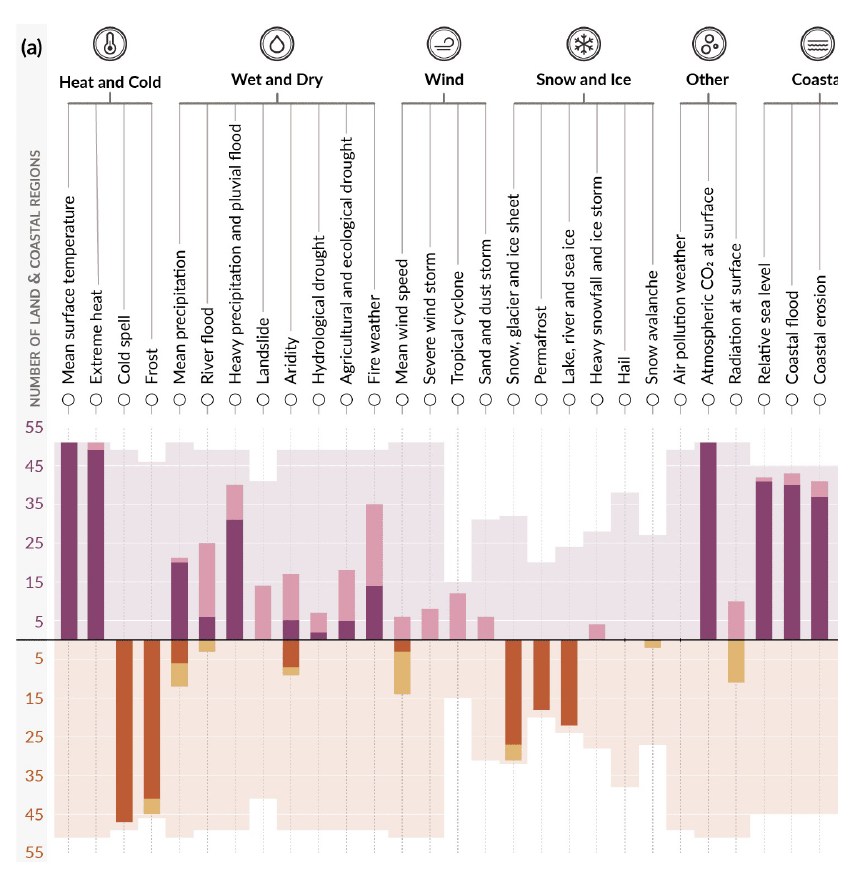
Figure 5. Synthesis of the number of regions where climate impact drivers (CID) are projected to change, increasing (top) and decreasing (bottom) with high/medium confidence levels (shading)